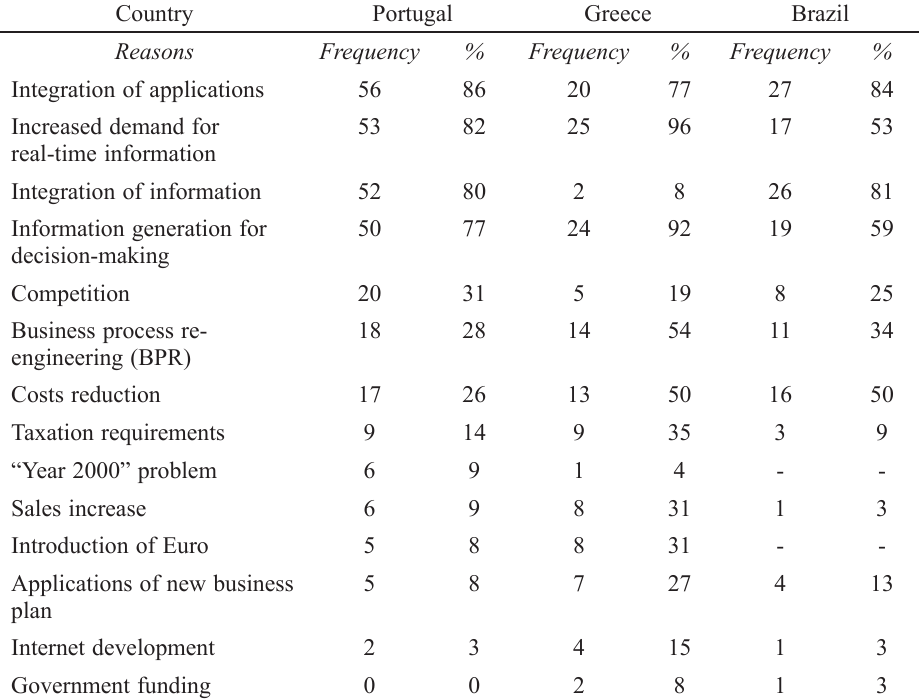
Table 2. Reasons for ERP